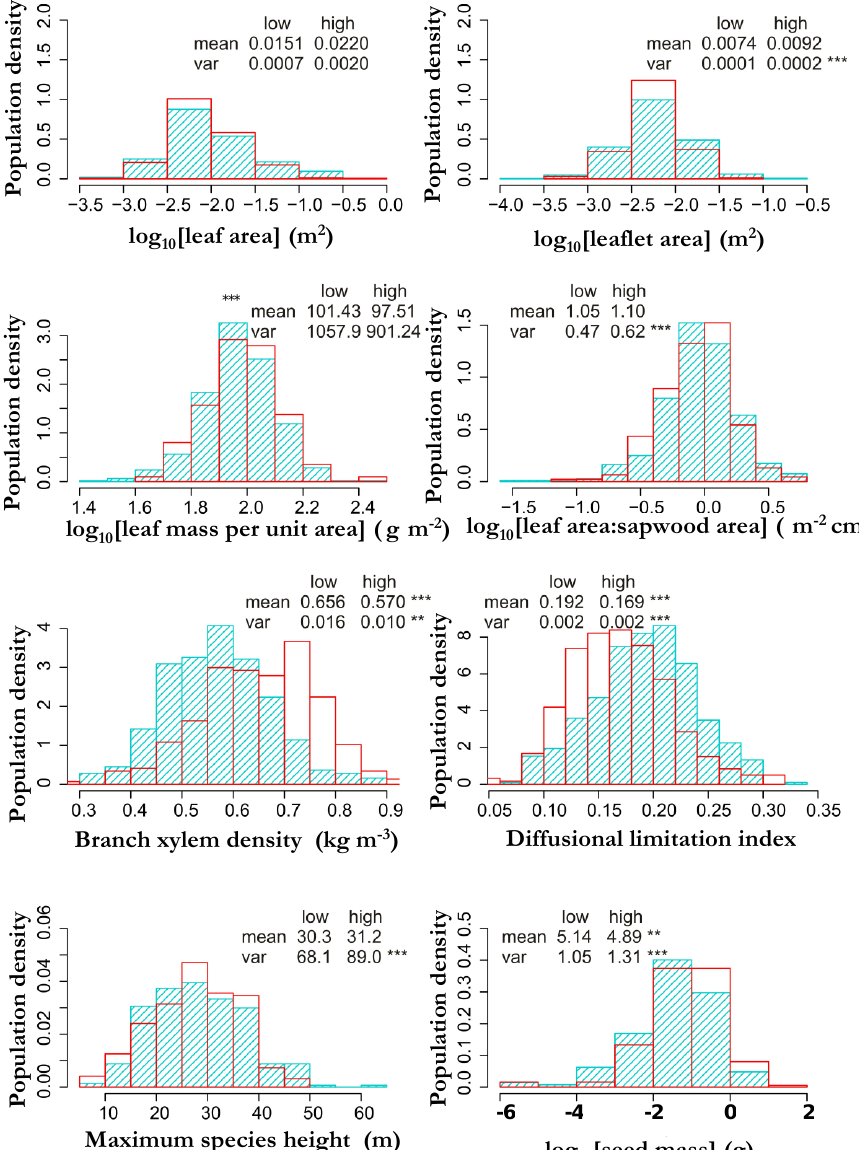
Fig. 1. Probability density histograms of raw data per fertility group for leaf area ( L A ; m 2 ), leaflet area ( ‘ A ; m 2 ), leaf mass per unit area ( M A ; gm − 2 ), (m 2 ), leaf area:sapwood area ratio ( 8 LS ; cm 2 m − 2 ), branch xylem density ( ρ x ; kg m − 3 ), (cid:11) = stomatal limitation index (dimensionless; see Eq. 1), species maximum height ( H max ; m) and seed mass ( S ; g). Open red bars represent low and blue dashed bars high soil fertility plots, as defined by the quantitative determinations of the level of total reserve bases from 0.0–0.3m depth (Fyllas et al., 2009; Quesada et al., 2010). Also given for each histogram are the mean and the variance for each trait. Significant differences in mean values and/or variances between the two fertility groups were identified with the Fligner-Killeen test respectively. Significance codes: *** < 0 . 001, ** < 0 . 01,* < 0 . 05.